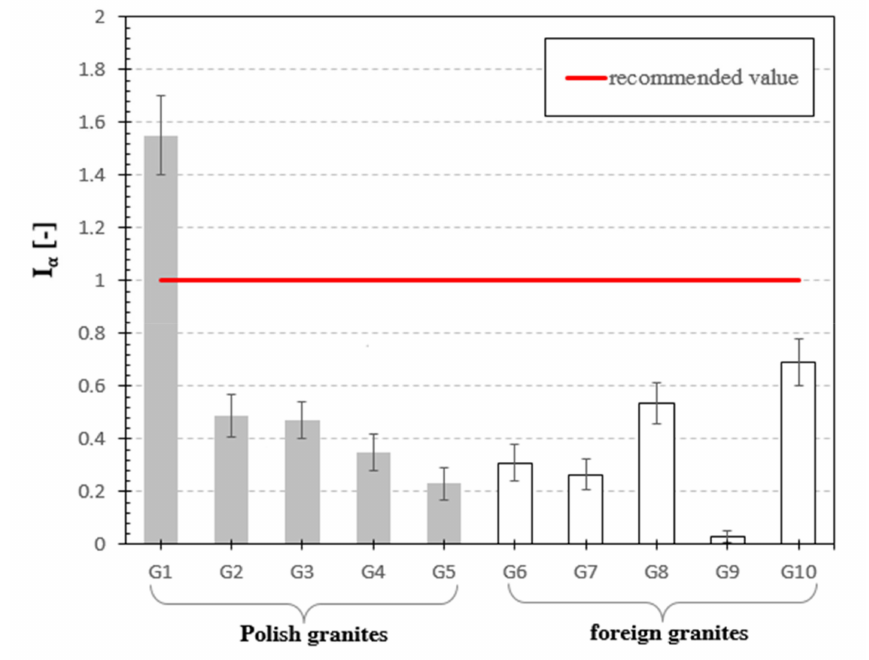
Figure 12. Alpha index for analyzed granite samples. The horizonal line indicates the recommended value of I α equal to 1 [24] for natural